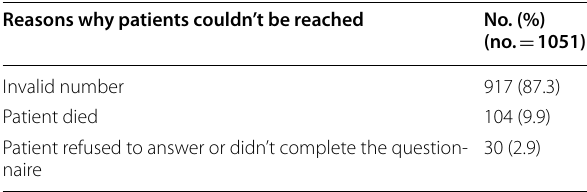
Table 2 Comparison between the compliant and the non- compliant patients’